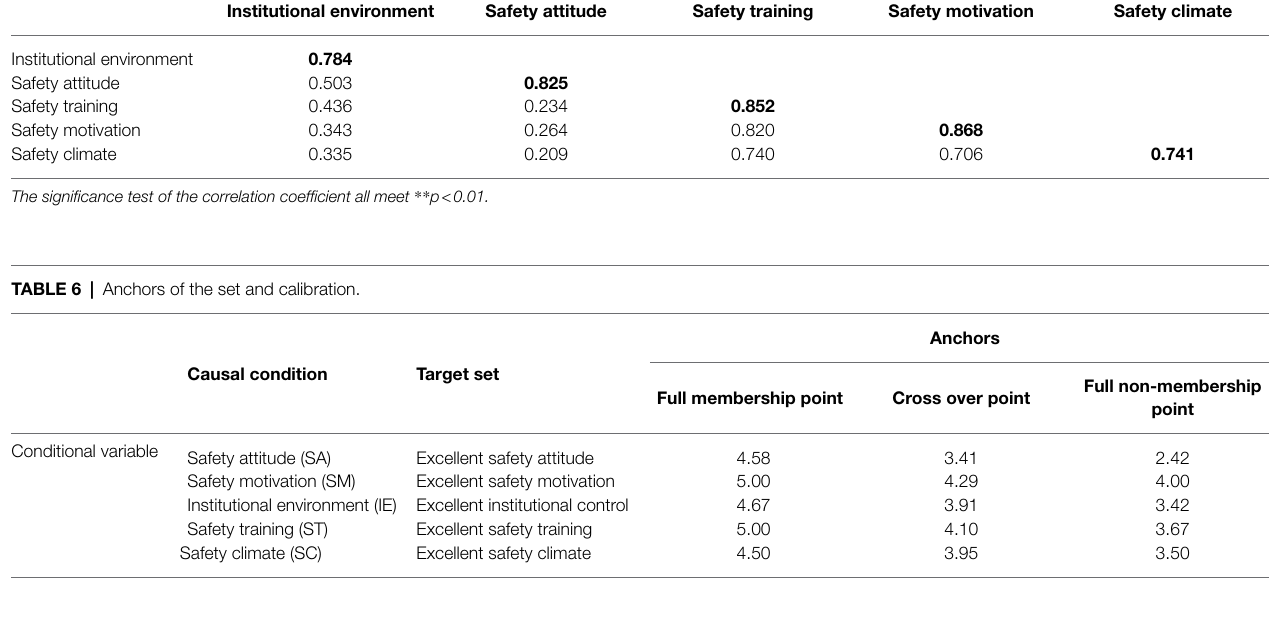
TABLE 5 | Correlation and differential validity of the variables.